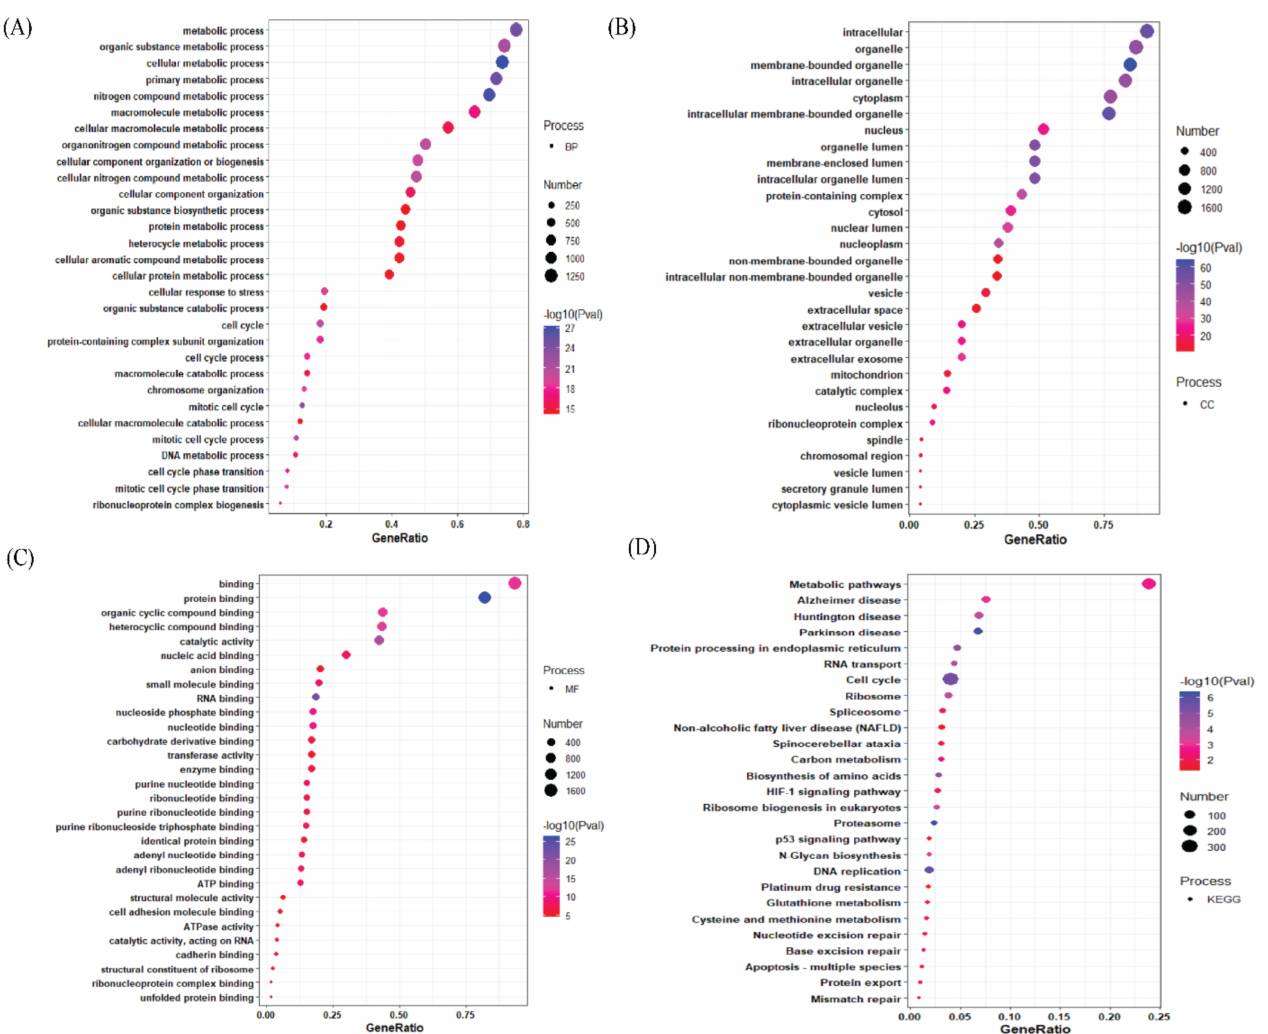
Figure 3. Gene enrichment analyses of upregulated DEGs: ( A ) The upregulated DEGs’ top30 enriched GO terms with logFC > |0.1| for each of the biological processes (BP). ( B ) The upregulated DEGs’ top30 enriched GO cellular component (CC). ( C ) The upregulated DEGs’ top-30 enriched GO molecular function (MF). ( D ) The upregulated DEGs’ top30 enriched GO KEGG pathway (KP). Gene Ratio is defined as the ratio between intersection size and query size. The number refers to interaction size, i.e., the number of genes corresponding to an ontology term and Gene Ratio denotes ratio between intersection and query